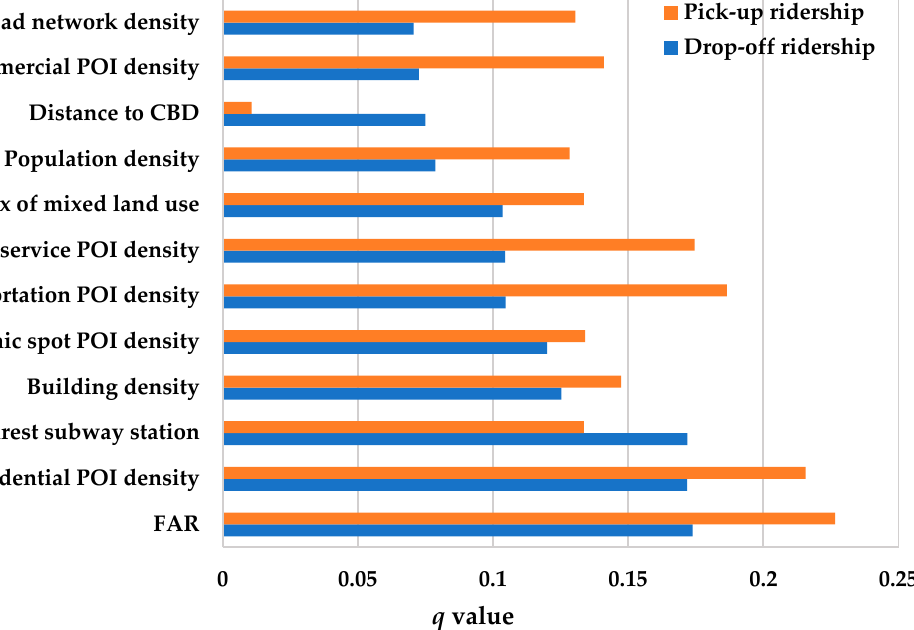
Figure 8. Contribution of single explanatory variables on pick-up and drop-off ridership in the morning peak hours by the factor detector.